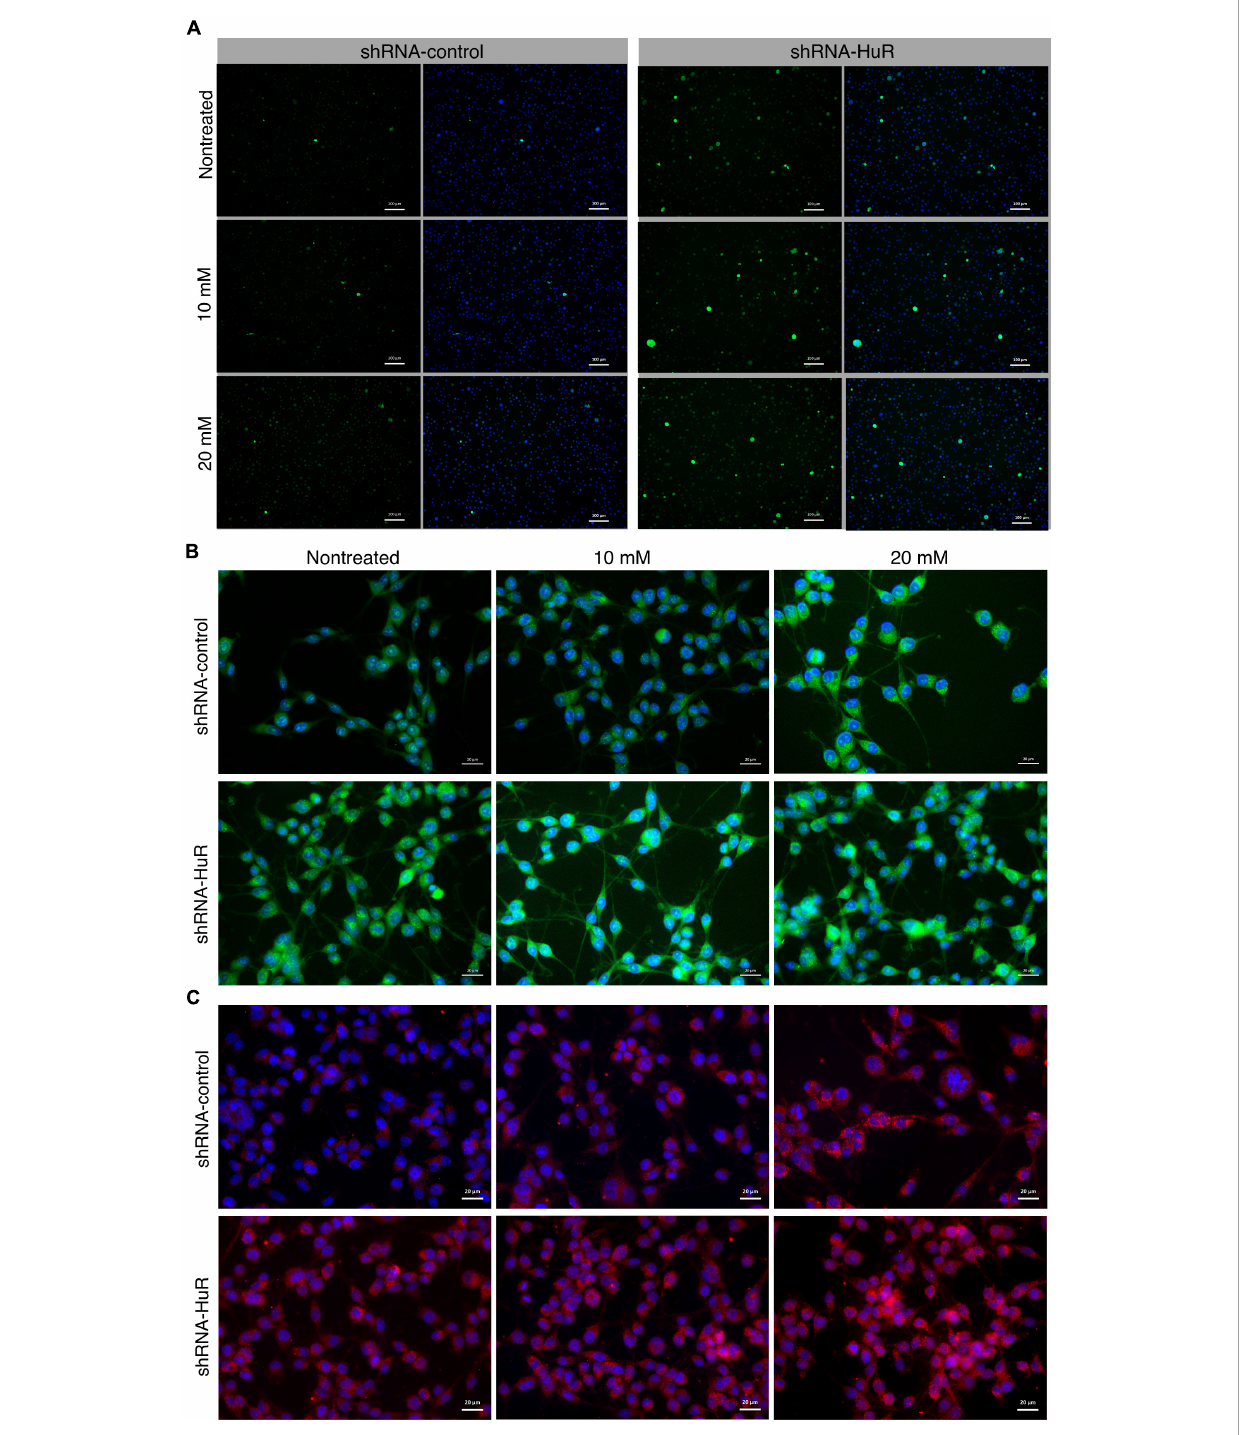
FIGURE3 In vitro validation of oxidative stress and apoptosis using NMDA excitotoxicity model in B35 cells. (A) Fluorescence microscopy images of apoptotic cells detected using the CaspACE assay in shRNA-control- and shRNA-HuR-transfected B-35 cells exposed to NMDA (10 or 20 mM) for 24 h. Scale bar = 100 µ m. CaspACE (green), DAPI (blue). (B) Fluorescence microscopy images of shRNA-control- and shRNA-HuR-treated B-35 cells exposed to NMDA (10 or 20 mM) for 24 h and then stained with MitoSOX Green marker of ROS (green); signals merged with DAPI staining (blue) are shown. Scale bar = 20 µ m. (C) Fluorescence microscopy images of shRNA-control- and shRNA-HuR-treated B-35 cells exposed to NMDA (10 or 20 mM) for 24 h and stained for 4-hydroxynonenal (4-HNE, red); images of signals merged with DAPI staining (blue) are shown. Scale bar = 20 µ